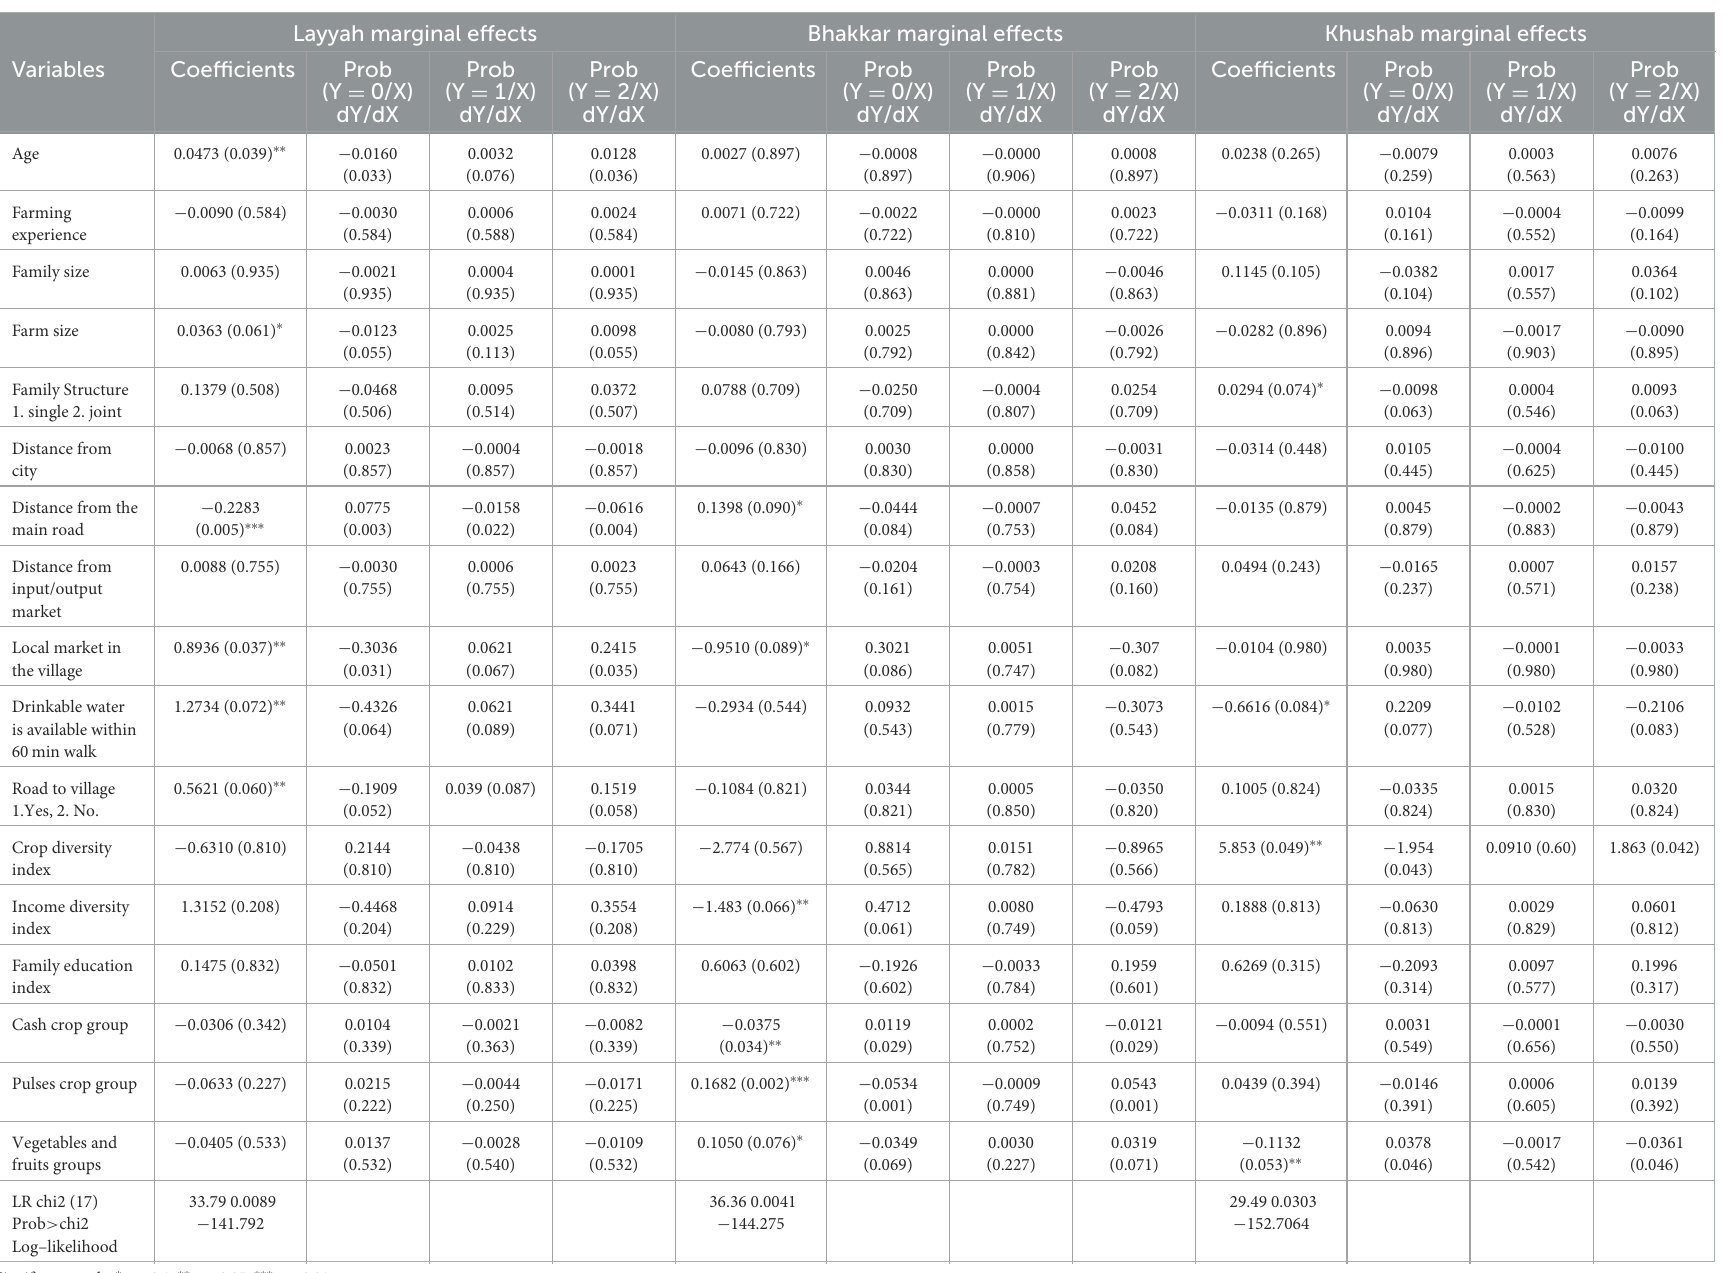
TABLE 4 Results of dietary diversity among adolescent as assessed by an analysis of agricultural and socioeconomic